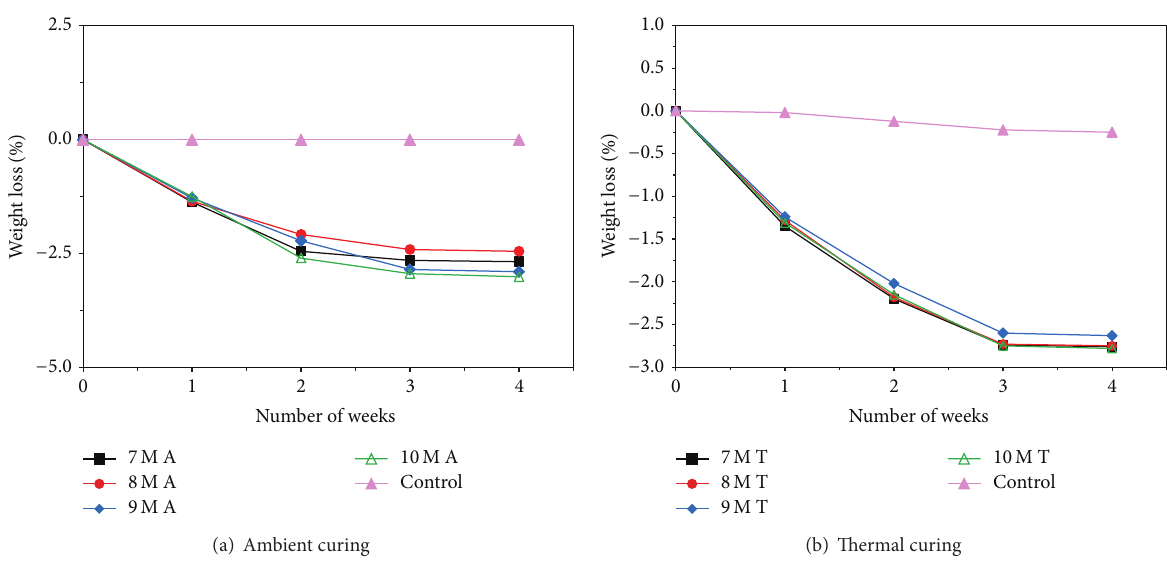
Figure 9: Weight loss for specimens immersed in 5% MgSO 4 after 28